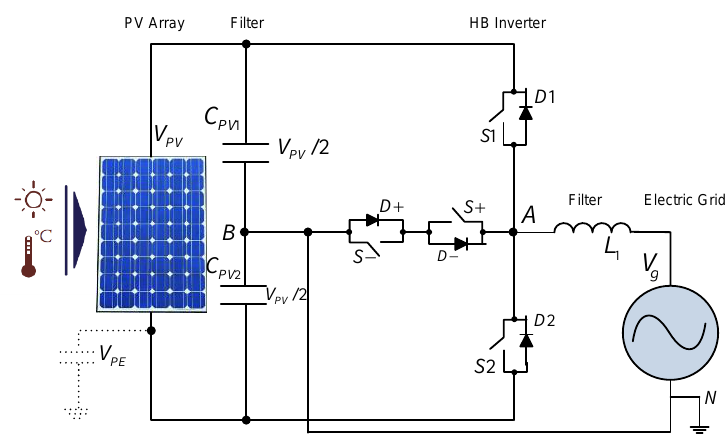
Figure 19. Schematic diagram of the Conergy NPC inverter [44,62].